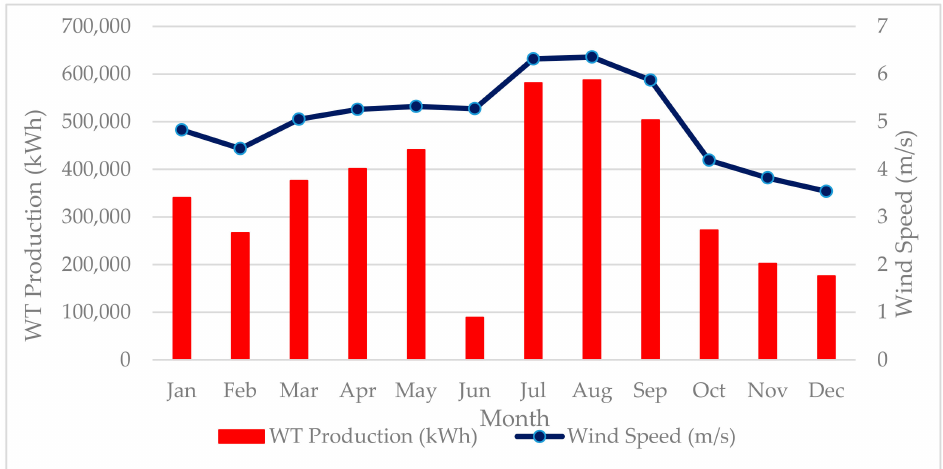
Figure 8. Mean wind speed per month.